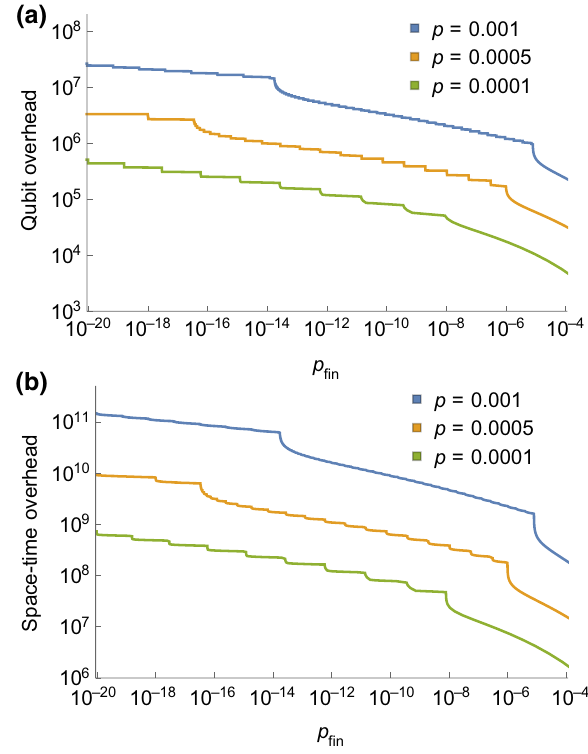
FIG. 24. (a) The qubit and (b) space-time overhead of state distillation as a function of the infidelity p fin of the output T state.